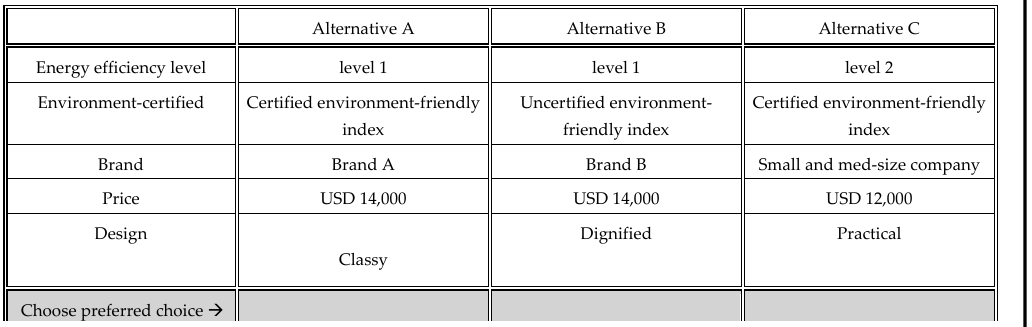
Figure 1. Sample questionnaire used for the conjoint analysis.